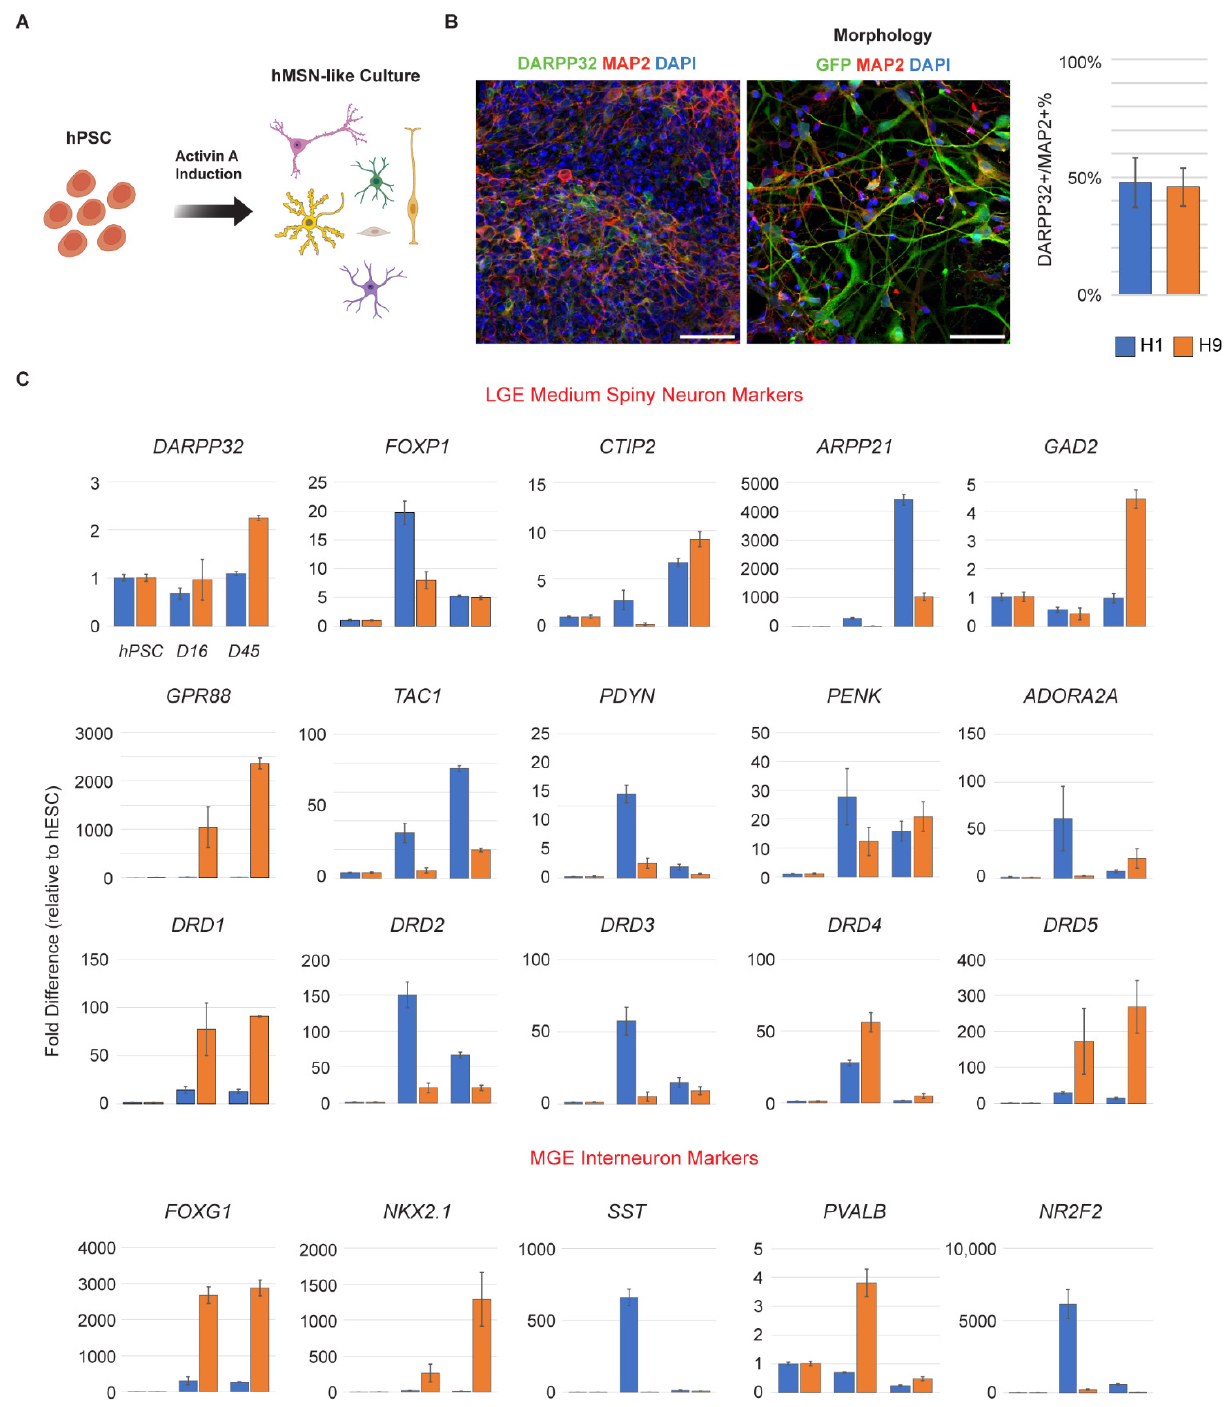
Figure 1. hPSC-derived neurons express markers of MSNs. ( A ) hPSCs are differentiated into hMSN-like cells following an Activin A induction protocol (Arber et al., 2015 [17]), ( B ) immunostained for MAP2+ (red), DARPP32 (green), and DAPI (blue) and quantified for DARPP32+ percentage. GFP-transfected hMSN-like cells were imaged to better highlight cell morphology. Scale bar = 50 µm. ( C ) QRT-PCR of RNA isolated from H1 (blue) and H9 (orange) hPSCs and hPSCs differentiated into hMSN-like cells at DIV 16 (D16) and DIV 45 (D45), for genes of interest. Values were normalized to HPRT1 mRNA levels in the same samples and expressed as normalized fold changes in hMSN-like versus hPSC cells. Values normalized to GUSB are provided in Figure S1. Gene categories are labeled in red. n = 3–4 independent replicates & 2 technical replicates. Error bars = Standard error.